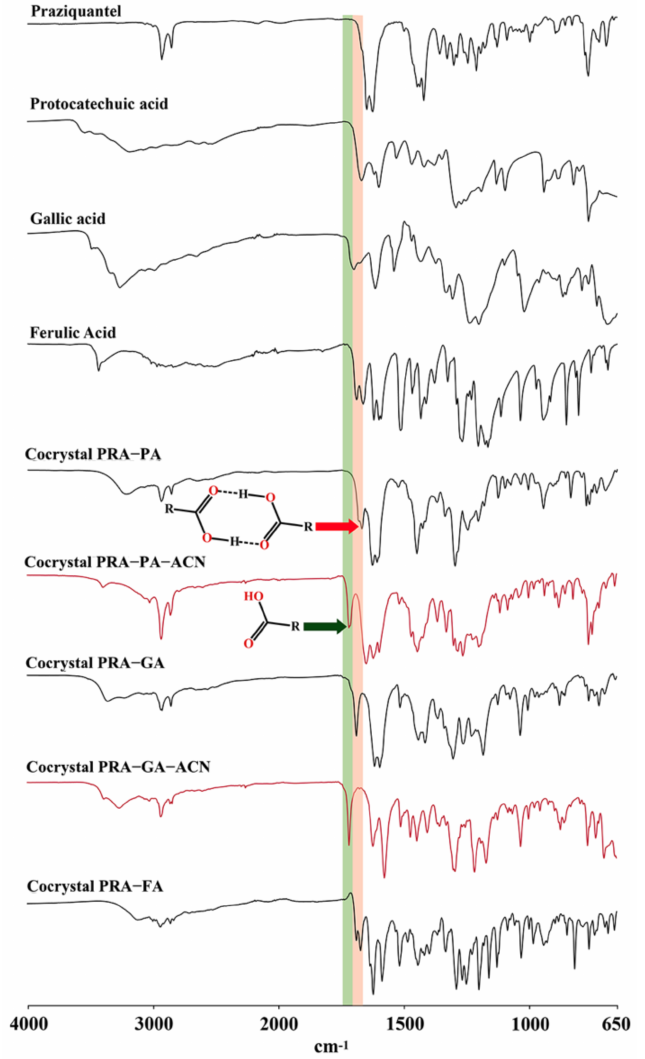
Figure 7. IR spectra of API, CCFs, the corresponding cocrystals (in black), and acetonitrile solvates (in